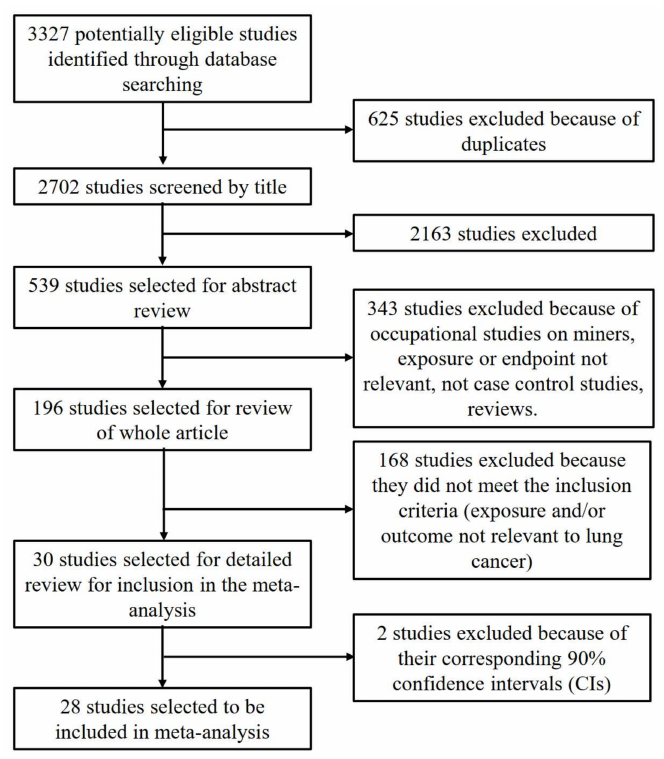
Figure 1. Flowchart of the study selection